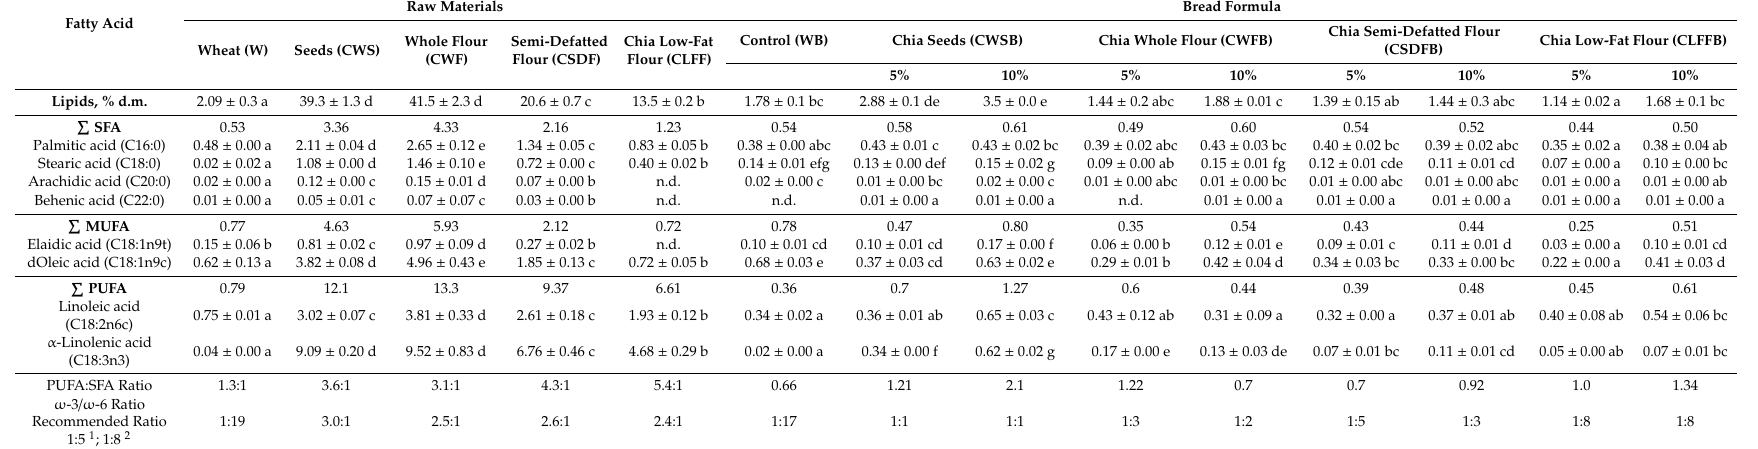
Table 2. Fatty acid composition of raw material and bread with 5% and 10% replacement used in this study, g / 100 g d.m. a . RawMaterials BreadFormula FattyAcid Wheat(W) Seeds(CWS) WholeFlour (CWF) Semi-Defatted Flour(CSDF) ChiaLow-Fat Flour(CLFF) Control(WB) ChiaSeeds(CWSB) ChiaWholeFlour(CWFB)